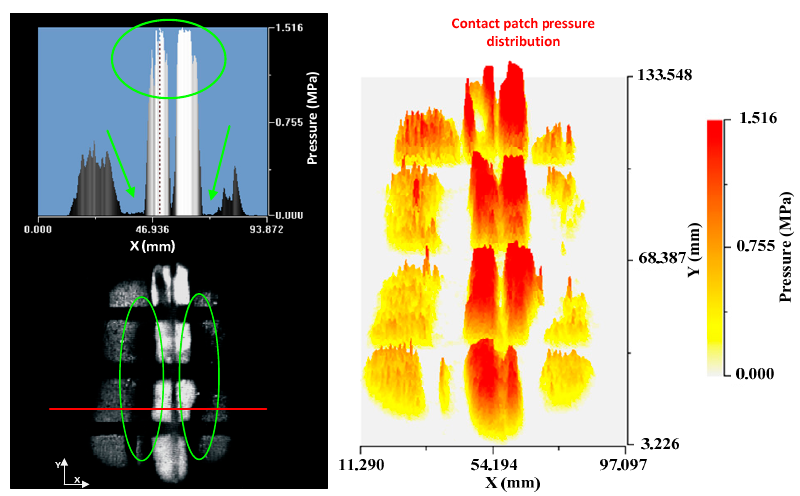
Figure 26. Cross-profile and pressure distribution ( left ); and contact patch pressure distribution ( right ).